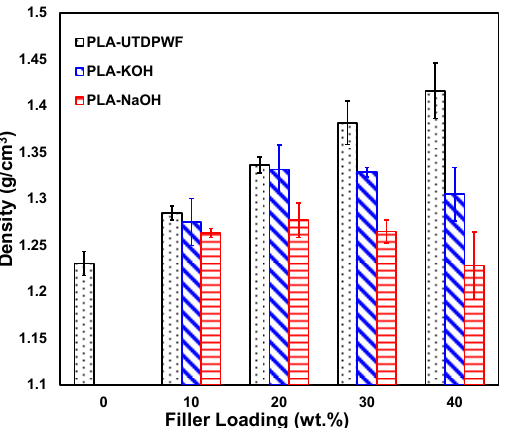
Figure 4. Density of PLA-UTDPWF, PLA-NaOH, and PLA-KOH composites.